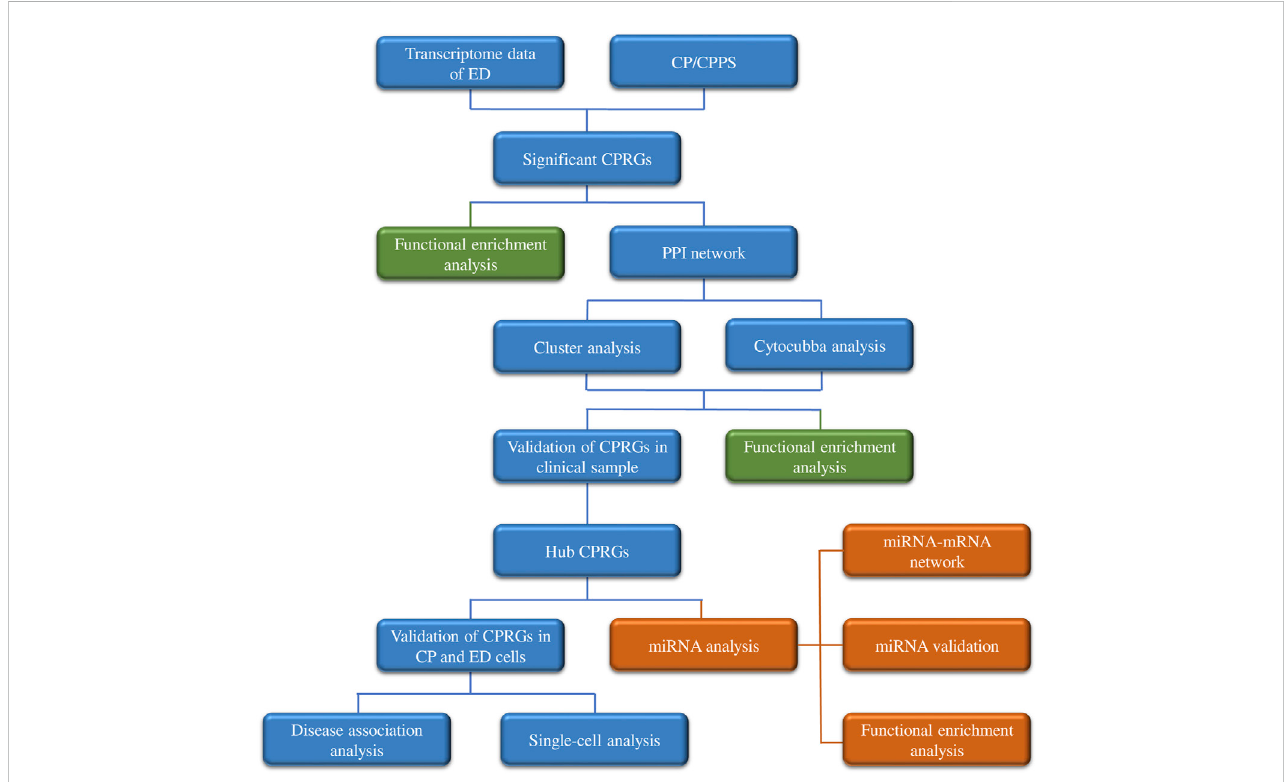
FIGURE 1 The analytic process of this research. ED, erectile dysfunction; CP, chronic prostatitis; CPPS, chronic pelvic pain syndrome; CPRGs, CP/CPPS-related genes; PPI, protein-protein interaction.